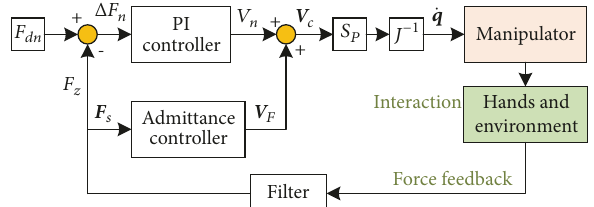
Figure 7: Block diagram of control system for polishing kinesthetic teaching. 𝐹 𝑠 ∈ R 6 is the sensed force and is used for teaching.